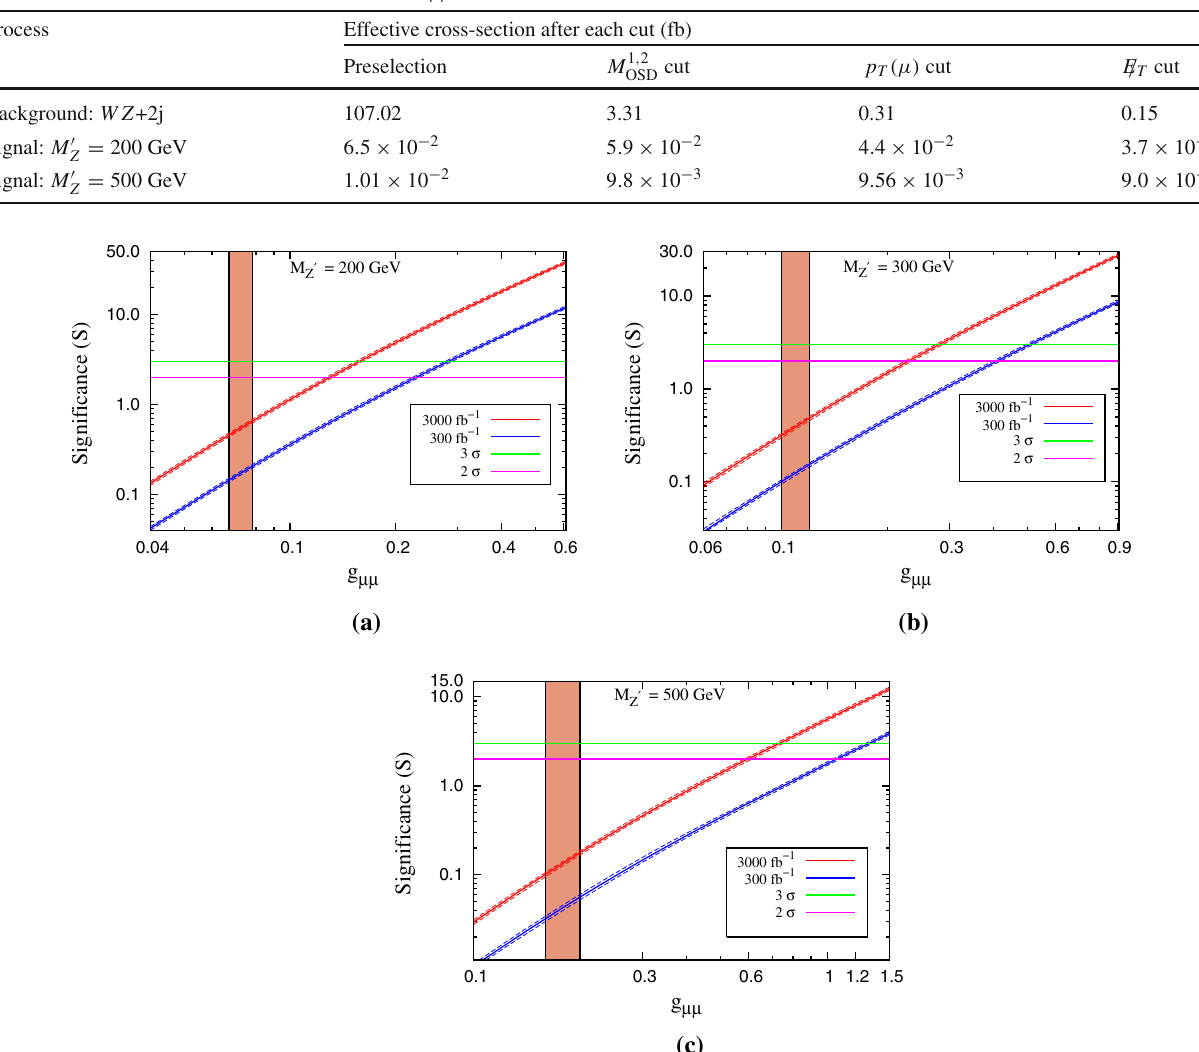
Fig. 12 Significance in the 3 μ + (cid:3) E T channel as a function of g μμ for M Z (cid:2) = 200 ( 12 a ), 300 ( 12 b ) and 500 ( 12 c ) GeV for The dashed lines represent the error band for the significance curves